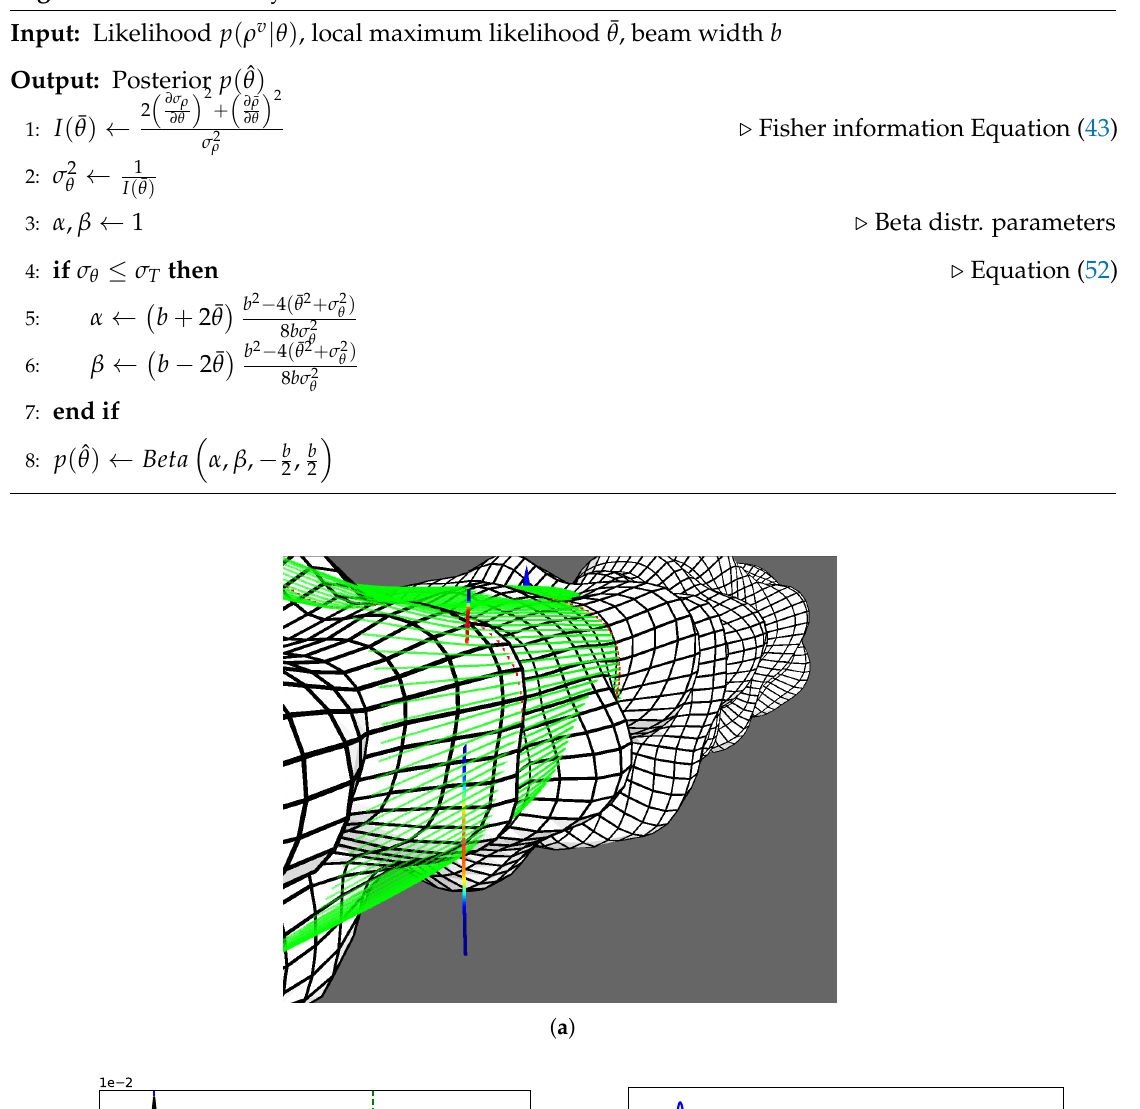
Algorithm 3 Uncertainty estimate.